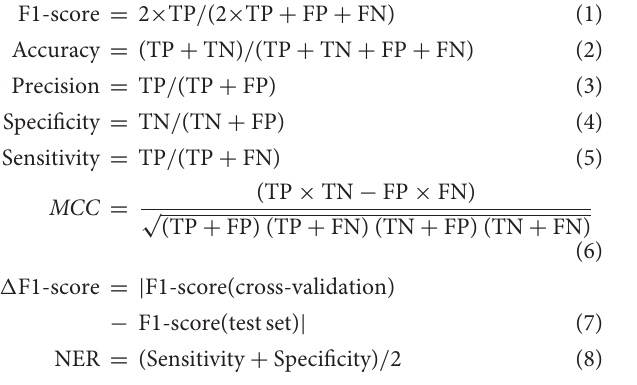
protocol ( Figure 1 ) to derive the machine-learning based models for the prediction of sweeteners and its